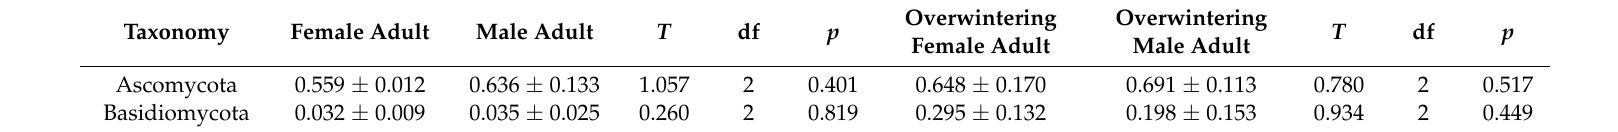
Table A4. The relative abundance of the different fungal taxa in different sexes of T. klimeschi at the phylum level.